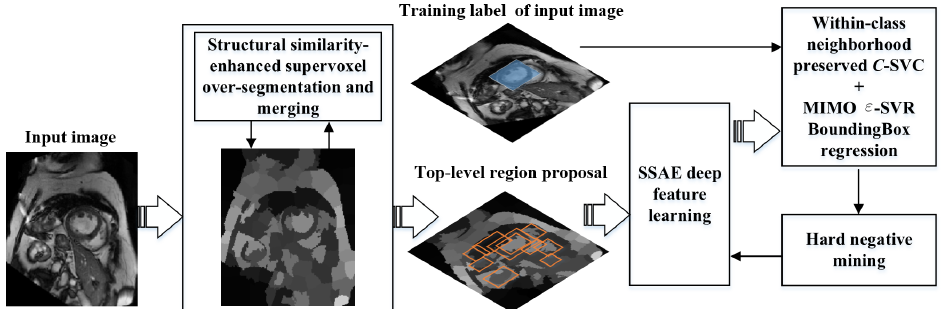
Figure 1. Training flowchart of proposed myocardium detection